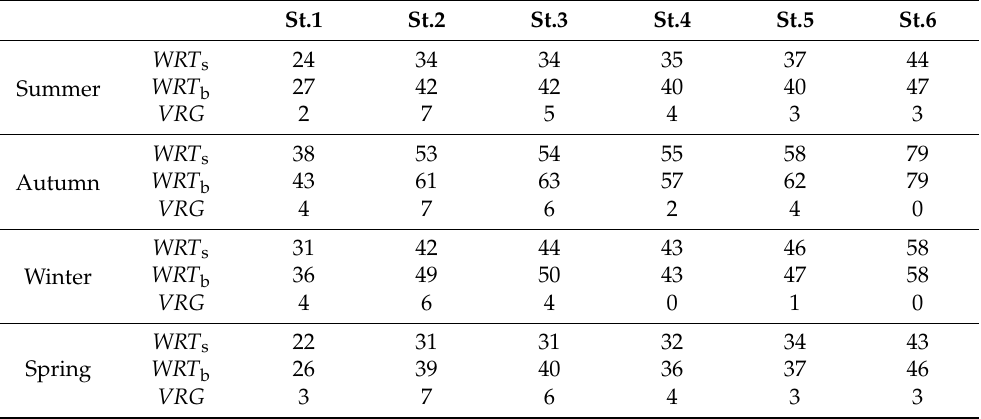
Table 4. Surface and bottom WRT values and vertical relative differences VRG computed for stations from 1 to 6. WRT are expressed in days while VRG are expressed in days per 100 m. Subscripted letters s and b stand for surface and bottom values,